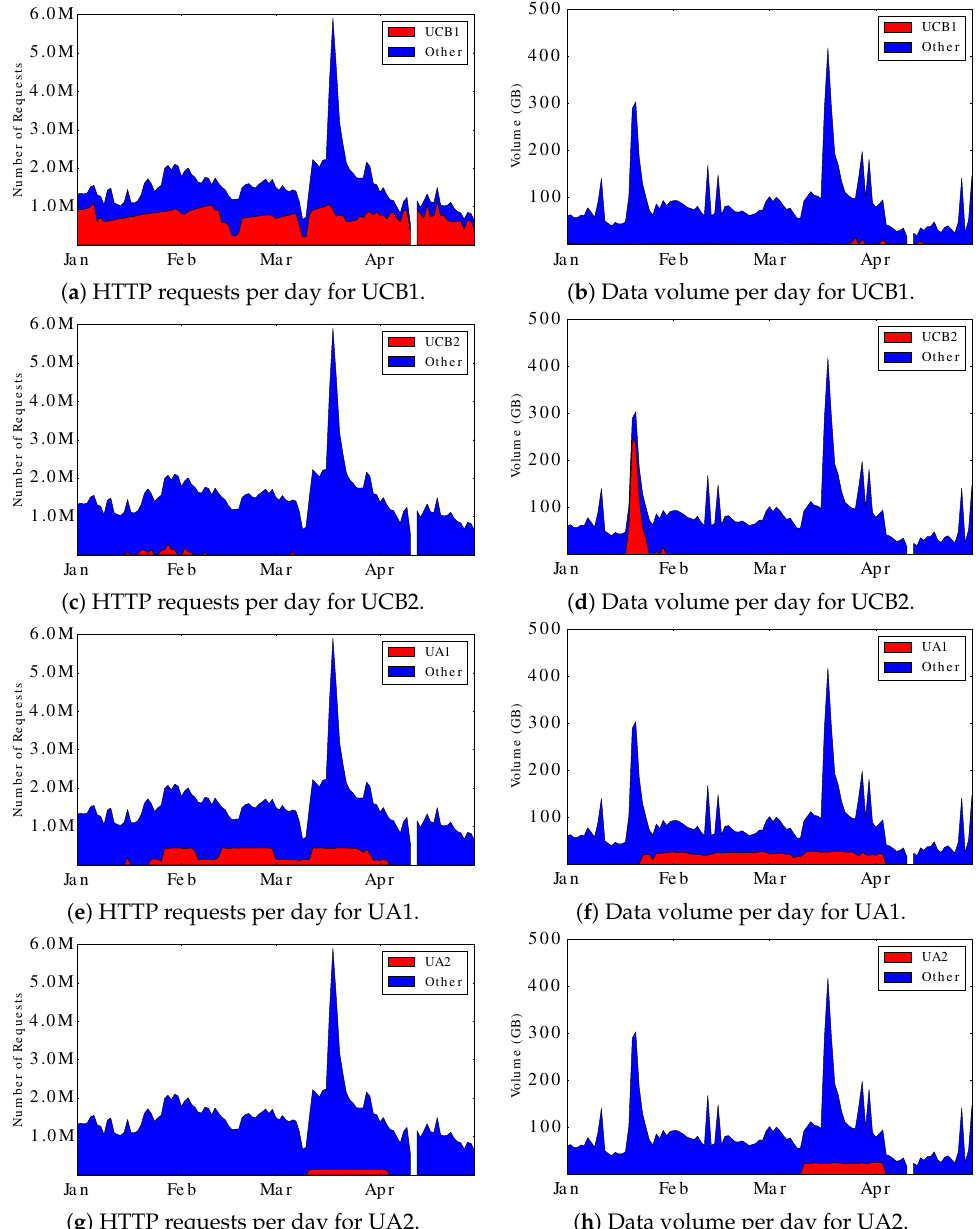
Figure 6. HTTP requests and data volume per day for UCB and UA Web